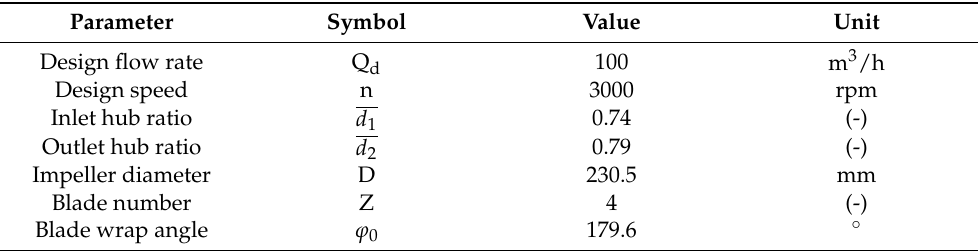
Figure 1. Three-dimension model of the multiphase pump.